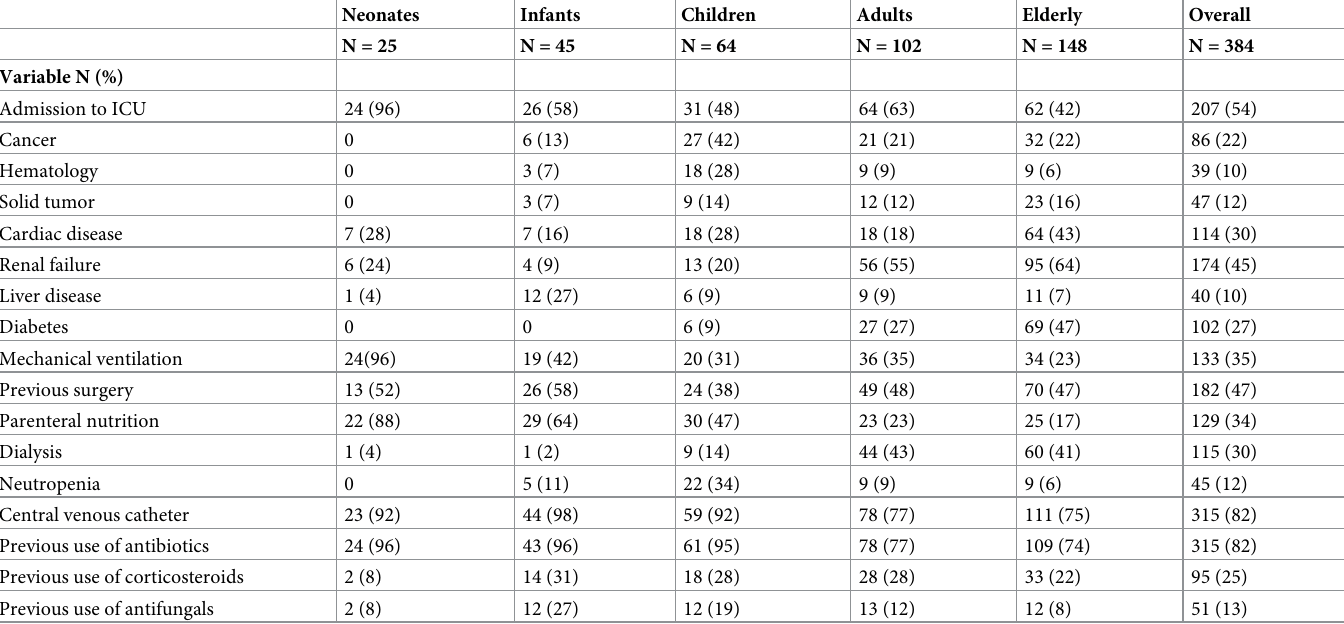
Table 4. Risk factors in 384 patients with candidemia, by age